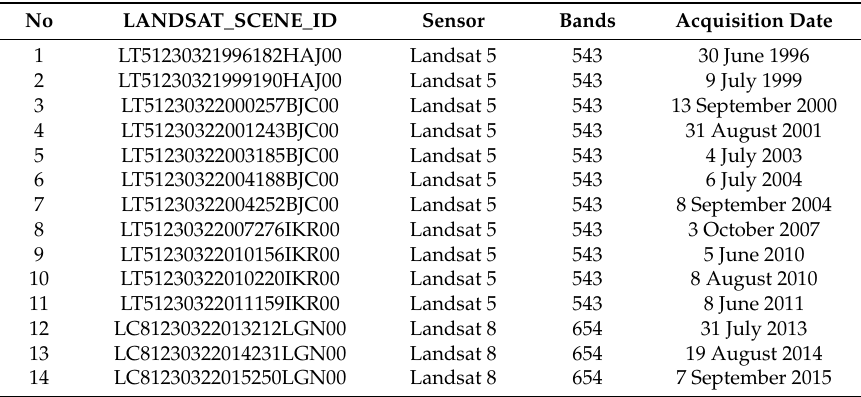
Table 1. RS (Remote Sensing) Image